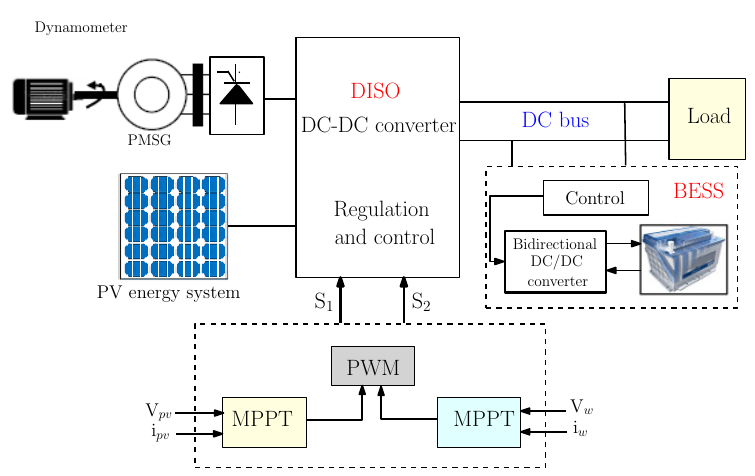
Figure 1. PV/wind HRES representation.